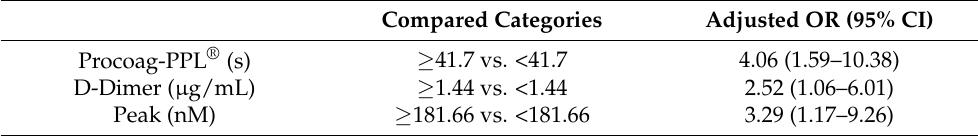
Table 4. Results of the multivariate logistic regression analysis examining the associations between the biomarkers and poor response/resistance to first line anti-myeloma treatment evaluated at 3 months follow up. Analysis was adjusted for clinical predictors, including dialysis, BMI, age, cardiovascular